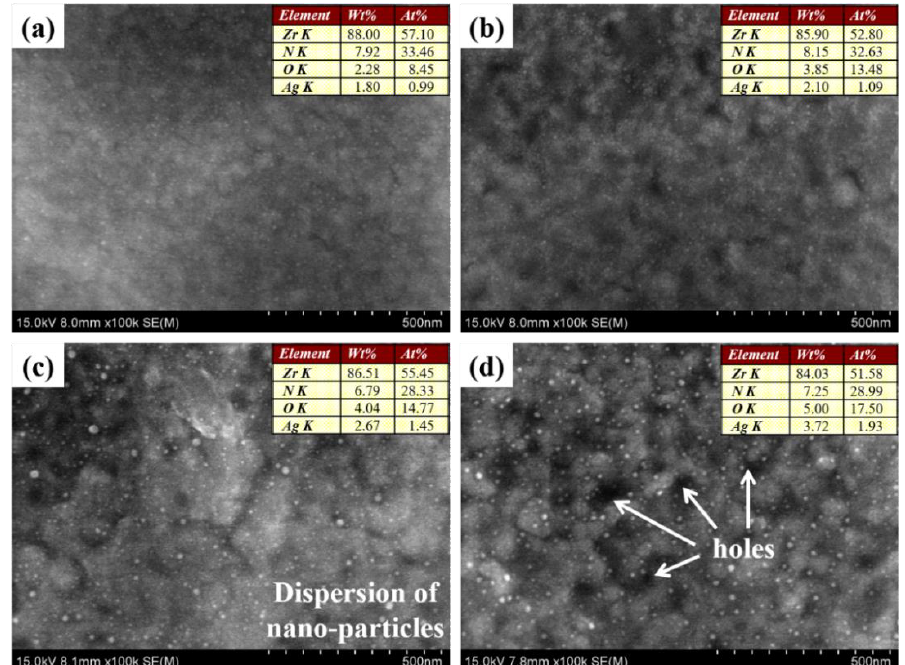
Figure 2. Surface morphologies for different doses of silver ions implanted on the surface of ZrN coating: ( a ) ZrN/Ag 2 O (1 × 10 16 icon/cm 2 ); ( b ) ZrN/Ag 2 O (5 × 10 16 icon/cm 2 ); ( c ) ZrN/Ag 2 O (10 × 10 16 icon/cm 2 ); and ( d ) ZrN/Ag 2 O (15 × 10 16 icon/cm 2 ). EDS analyses for Zr, N, O and Ag elements are embodied in the images.